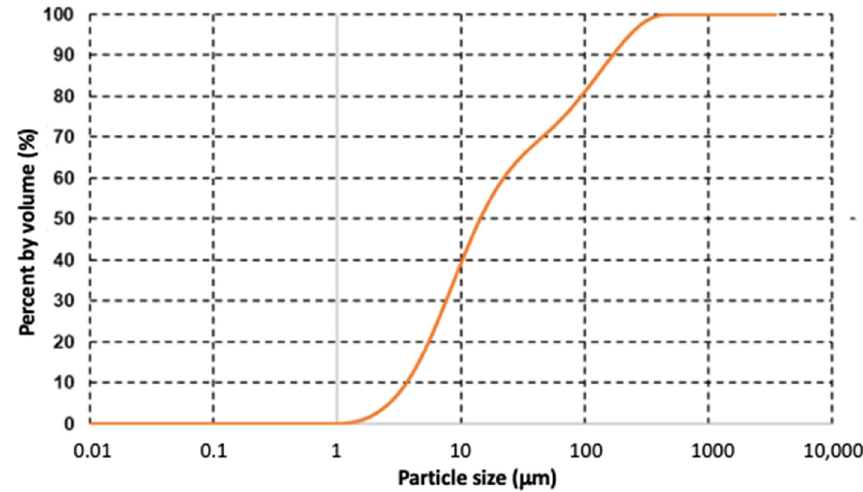
Figure 11. Particle size distribution of lanthanum oxide.